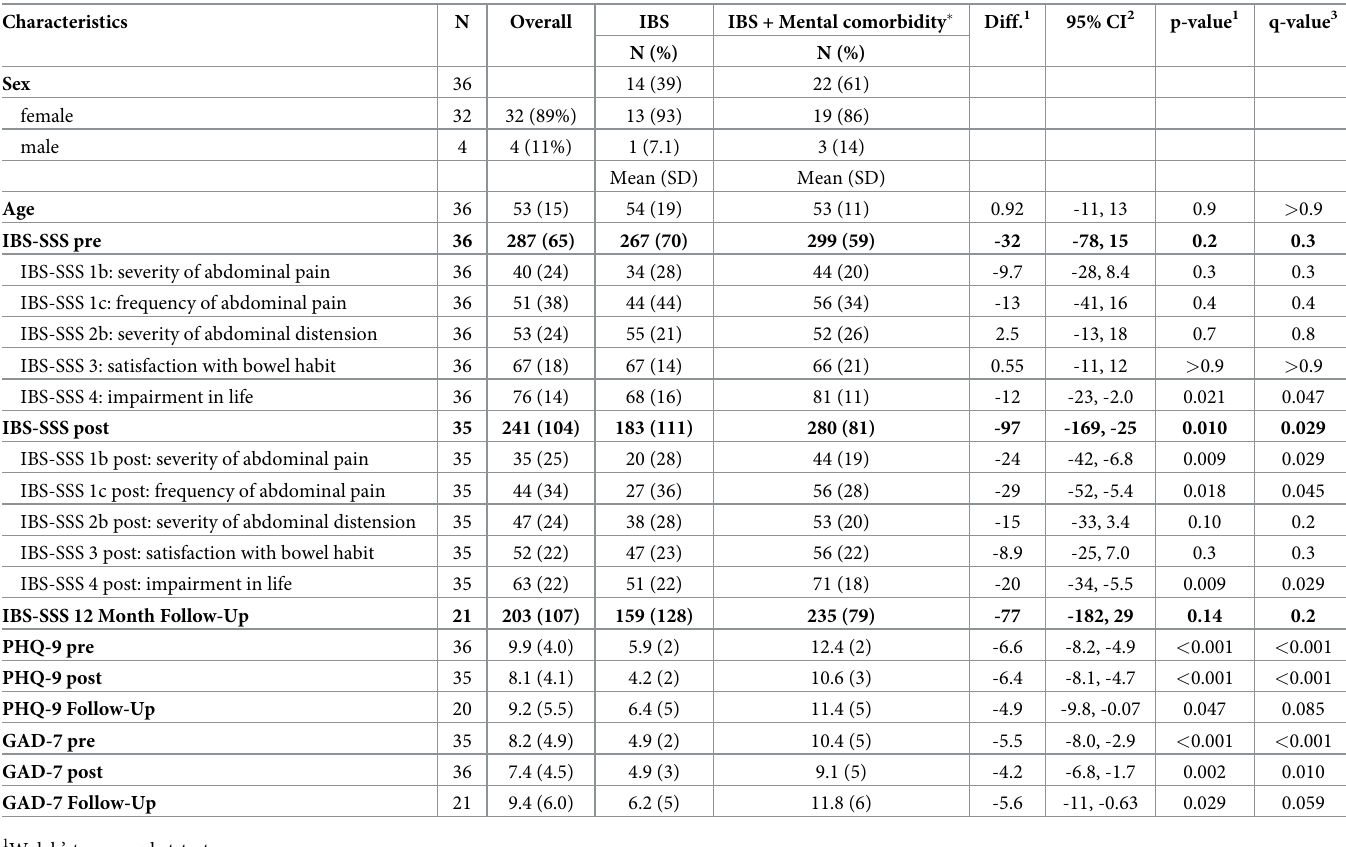
Table 2. Severity, depression and anxiety scores among IBS patients, pre, post AMT and at 12 month follow-up. Characteristics N